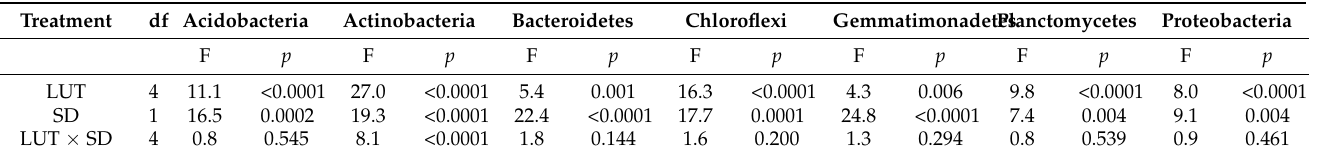
Table 2. Results of two-way ANOVA for the effects of land use type (LUT) and soil depth (SD) on the absolute abundance of Acidobacteria, Actinobacteria, Bacteroidetes, Chloroflexi, Gemmatimonadetes, Planctomycetes and Proteobacteria, F: F-value.